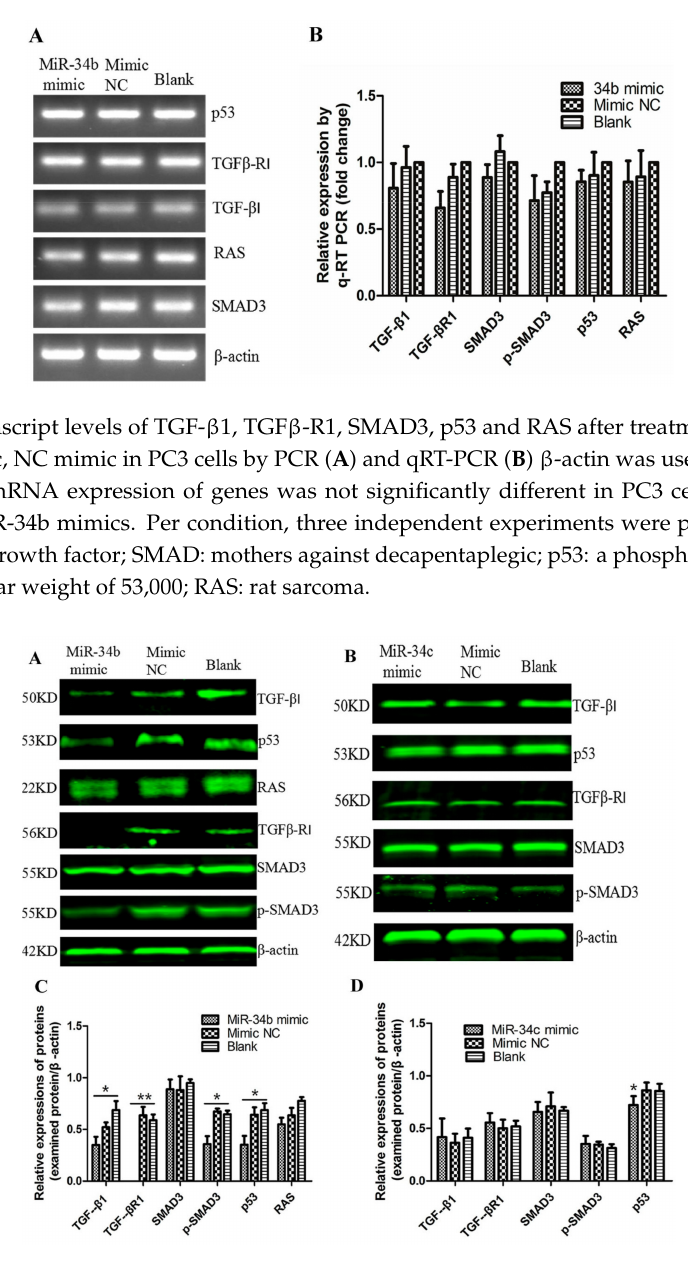
Figure 11. Western blot analysis of TGF- β 1, TGF β -R1, SMAD3, p-SMAD3, p53, and RAS after ectopic expression of miR-34b/c in PC3 cells. ( A ) Protein levels of TGF- β 1, TGF β -R1, and p53 and phosphorylation of SMAD3 in miR-34b mimic-treated PC3 cells were lower compared to that in mimic NC or blank control groups. Protein levels of RAS were not significantly different between groups; ( B ) In miR-34c mimic-treated PC3 cells, protein levels of TGF- β , TGF β -R, p53 and phosphorylation of SMAD3 were not significantly different when compared to control groups; ( C , D ) The relative protein levels were calculated by Image J software (Rawak Software, Inc., Dresden, Germany), and β -actin was used as a loading control. ** p < 0.01 * p < 0.05 vs. mimic NC or blank group. Per condition, three independent experiments were